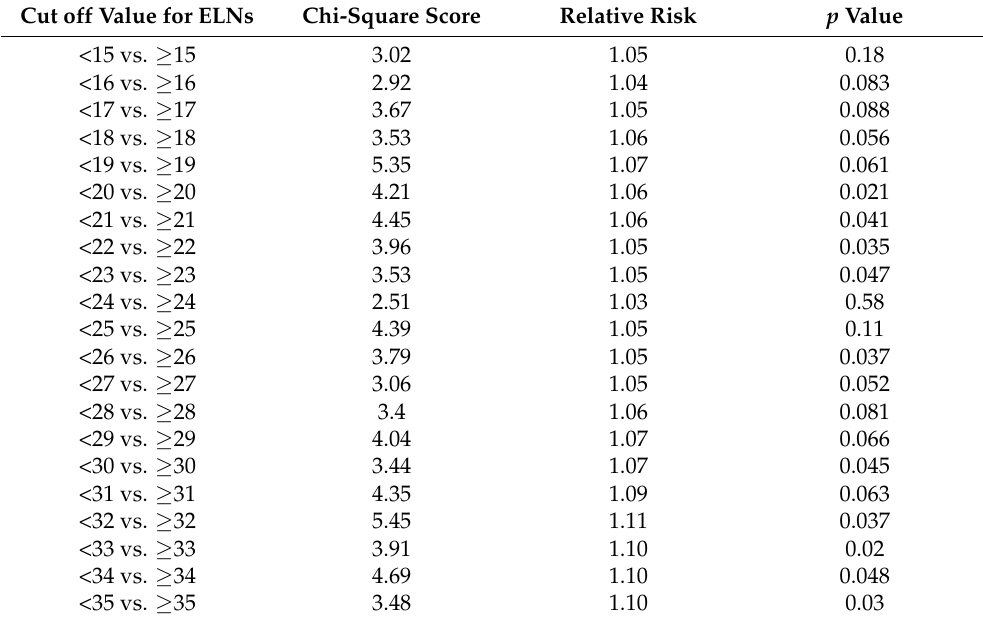
Table 3. Clinical characteristics of patients in the study before and after propensity score match- ing.